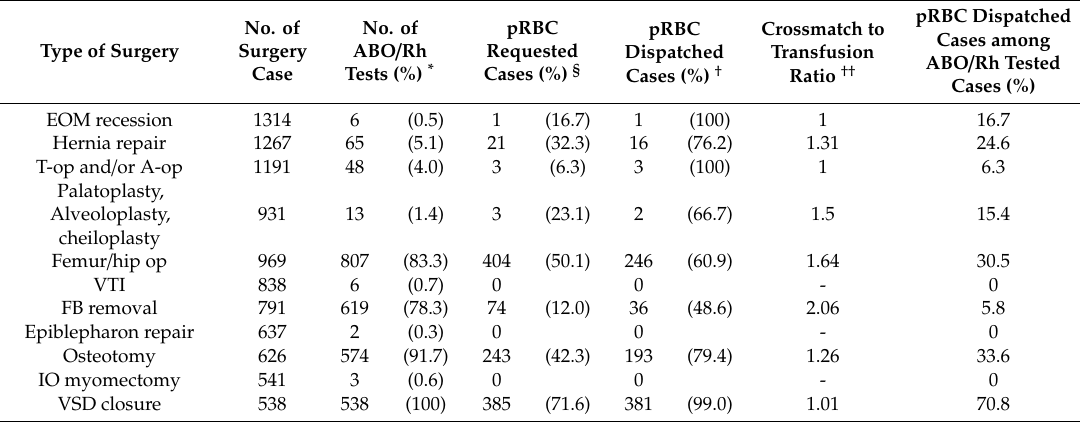
Figure 1. Temporal trend of ABO / Rh type and screening and transfusion. pRBC = packed red blood cell (* p < 0.05 compared to year 2007). Table 2. The incidence of ABO / Rh type and screening and transfusion in ten most frequently performed